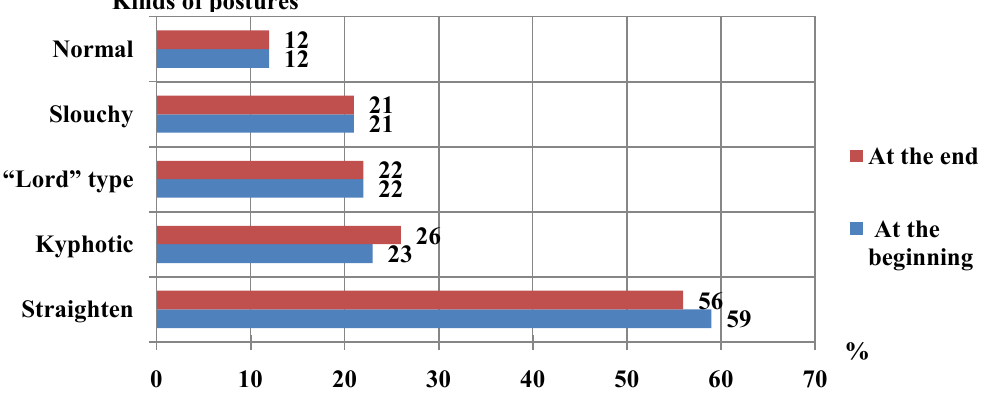
Fig.3. Quantitative indicators of 12-13 years old girls with different kinds of postures during academic year